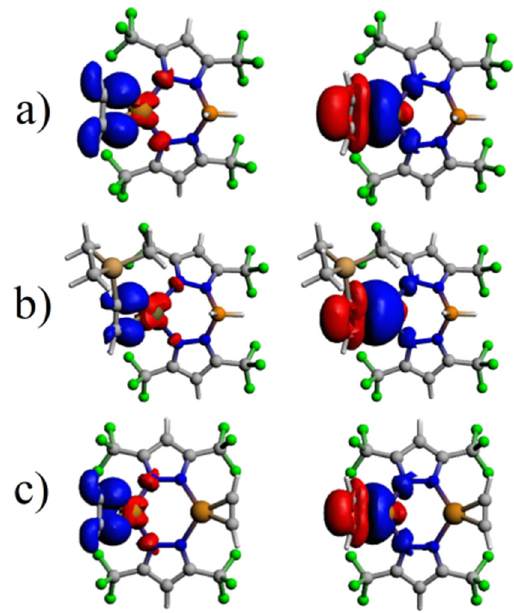
Figure 4. Representative deformation densities accounting for the π -backbonding (left) and σ - donation (right) contribution to the bonding scheme in the formation of alkyl copper complexes (from top to bottom) for ( a ) [H 2 B(3,5-(CF 3 ) 2 Pz) 2 ]Cu(HC ≡ CH) ( 4 ), ( b ) [H 2 B(3,5-(CF 3 ) 2 Pz) 2 ]Cu(HC ≡ CSiMe 3 ) ( 5 ) and ( c ) the dinuclear Cu 2 ( µ -[3,5-(CF 3 ) 2 Pz]) 2 (HC ≡ CH) 2 ( 10 ). Charge flow from red to blue.